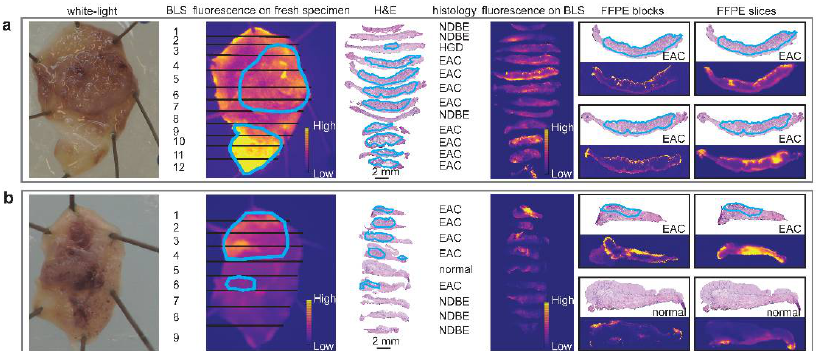
Figure 3. The ex vivo imaging and histology correlation of two novel tracers. The histology correla- tions of SULF1-800CW ( a ) and SPARC-800CW ( b ) on fresh EMR specimens, bread-loaf slices, FFPE blocks, and 4 µm FFPE slices are shown. The dysplastic or neoplastic BE tissue is delineated with blue circled lines. The fluorescence of both SULF1-800CW and SPARC-800CW tracers correlates well with the histology. BLS: bread-loaf slices; EAC: esophageal adenocarcinoma; FFPE: formalin-fixed and paraffin-embedded; H&E: hematoxylin and eosin; HGD: high-grade dysplasia; NDBE: non-dysplastic Barrett’s esophagus; normal: normal squamous epithelium. The mean fluorescence intensity (MFI) was calculated in tissue without coagulation.